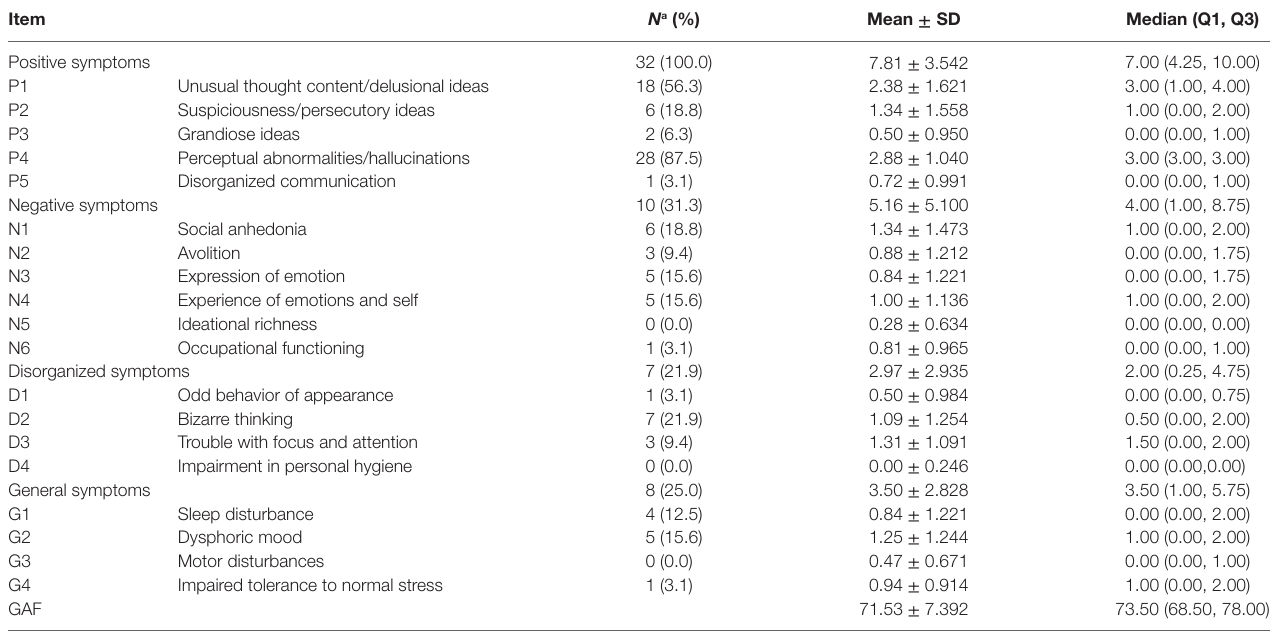
TaBle 2 | Baseline-attenuated psychotic characteristics.